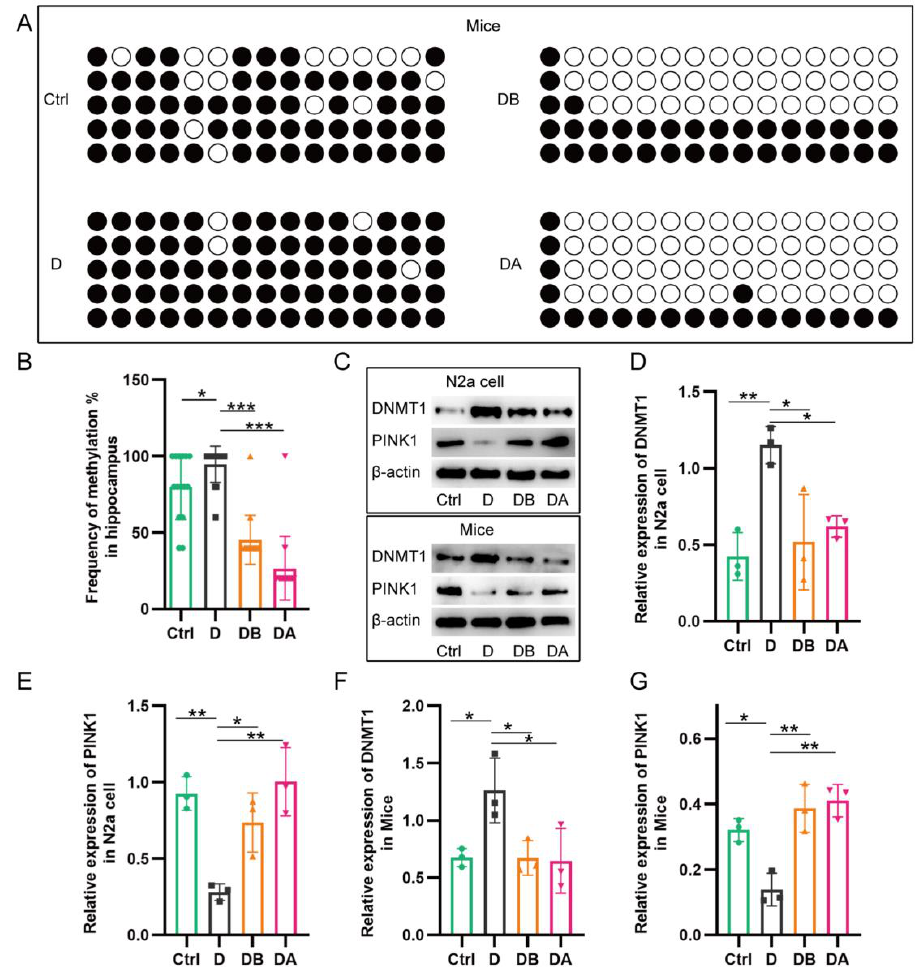
Figure 7. Effect of BBR and D-ribose on methylation of PINK1 promoter. Compared with the control group, the methylation of PINK1 promoter in the D group was significantly increased, which could be reversed by adding BBR, the same effect as DNA methylation inhibitor 5-Azacytidine (DA group) ( A , B ). In in vitro and in vivo experiments, compared with the control group, the D group had increased expression of DNMT1, but decreased PINK1. Compared with the D group, PINK1 was overexpressed; while DNMT1 was reduced in DB and DA group ( C – G ). BSP was used to detect the methylation level of PINK1 promoter in hippocampus of APP/PS1 mice, dot plots and the statistical chart ( A , B ); Western blot was used to analyze the expression of PINK1 and DNMT1 in N2a cells and APP/PS1 mice ( C , G ). * p < 0.05, ** p < 0.01, *** p < 0.001. Abbreviation: Ctrl, Con-